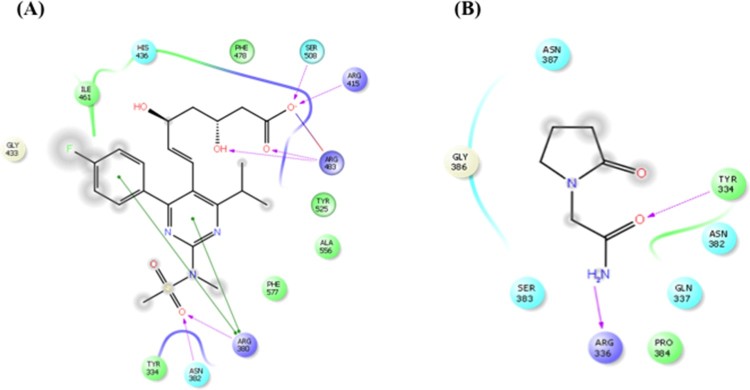
Molecular docking study of
rosuvastatin and piracetam to Nrf2. (A) 2D ligand interaction
representation of rosuvastatin showing hydrogen bond interaction
with purple color arrow line and pi–pi stacking with green
line in the binding site of nrf2. (B) 2D ligand interaction
representation of piracetam showing hydrogen bond interaction with
purple color arrow line and pi–pi stacking with green line in
the binding site of nrf2.